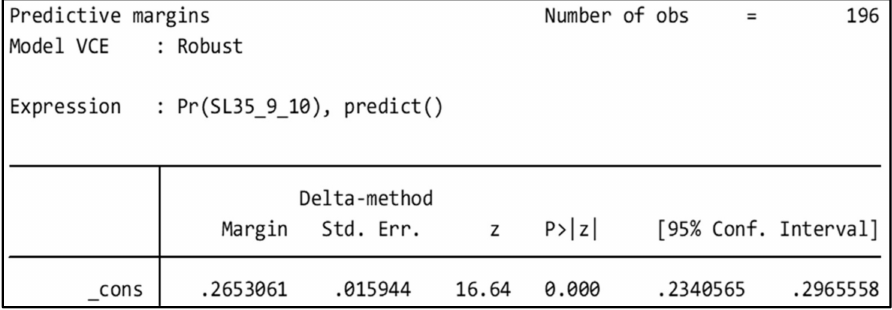
Figure 1. Predictive margins of model